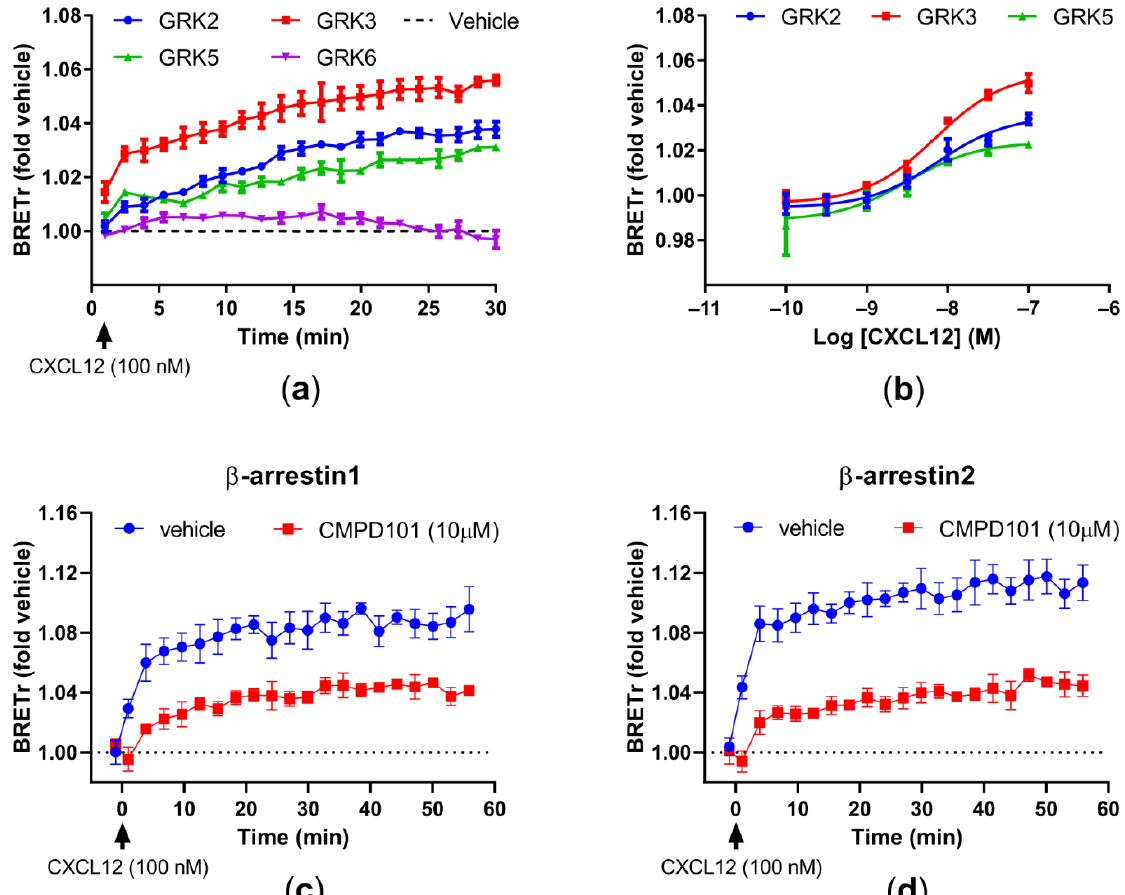
Figure 2. Influence of GRKs recruitment to ACKR3 upon CXCL12 stimulation. ( a ) CXCL12-induced GRKs recruitment to ACKR3 over time as measured by BRET in HEK293T cells; ( b ) Agonist-induced GRKs recruitment to ACKR3 by increasing concentrations of CXCL12 as measured by BRET in HEK293T cells after 30 min stimulation; ( c ) CXCL12-induced β -arrestin1 recruitment to ACKR3 over time, in presence or absence of 10 µ M compound101 as measured by BRET in HEK293T cells; ( d ) CXCL12-induced β -arrestin2 recruitment to ACKR3 over time, in presence or absence of 10 µ M compound101 as measured by BRET in HEK293T cells. Representative curves of three independent experiments with triplicates shown as mean ± SD.